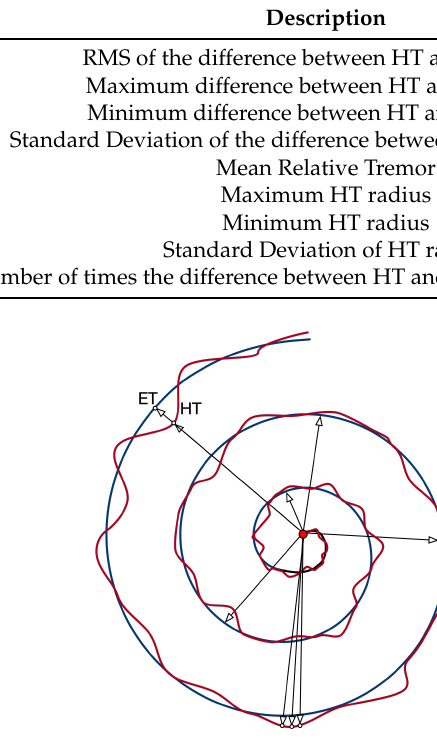
Figure 3. An example of the feature extraction process for a spiral. The blue line is the ET, while the red line is the HT. The arrows indicate the radii for both ET and HT, the white circles indicate the intersection of a radius with the ET and the HT traces and the red circle represents the center of the ET. In order to compute all the features, the radius is shifted by using a predefined spanning angle (for a detailed description of the feature extraction process see Reference [21].